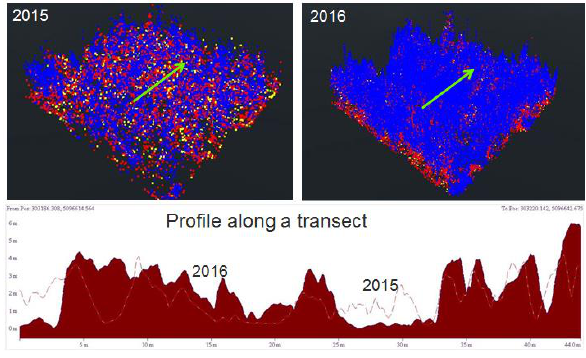
Figure 5. Growth in the understorey. Distribution of multi return echoes (blue-1st, red – 2nd, yellow – 3rd, green – 4th returns) on the top and a profile description along a transect in the sub canopy of a sample plot of 10 m 2 .